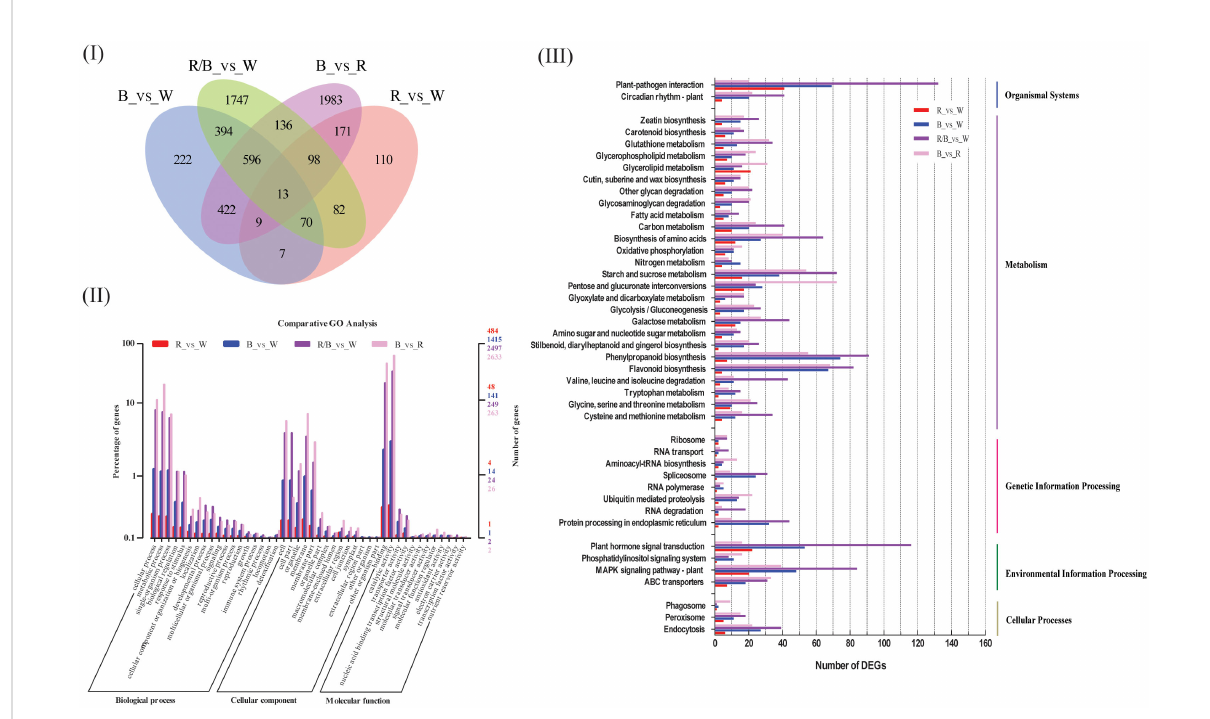
FIGURE 2 Functional annotation results of the genes differentially expressed in blue (B) , red (R) , and red/blue (60R/40B) when compared with those of the corresponding control (white light) and the comparison of B vs. R using the transcriptome data from blueberry ‘ Misty ’ leaves; (I) Venn diagram showing the shared and common DEGs for all light quality treatments; (II) Functional annotation of the DEGs based on the Clusters of Orthologous Groups (COG) database; (III) Annotation information obtained from the Gene Ontology (GO) database; (IV) Functional classi fi cation of DEGs based on the Kyoto Encyclopedia of Genes and Genomes (KEGG)